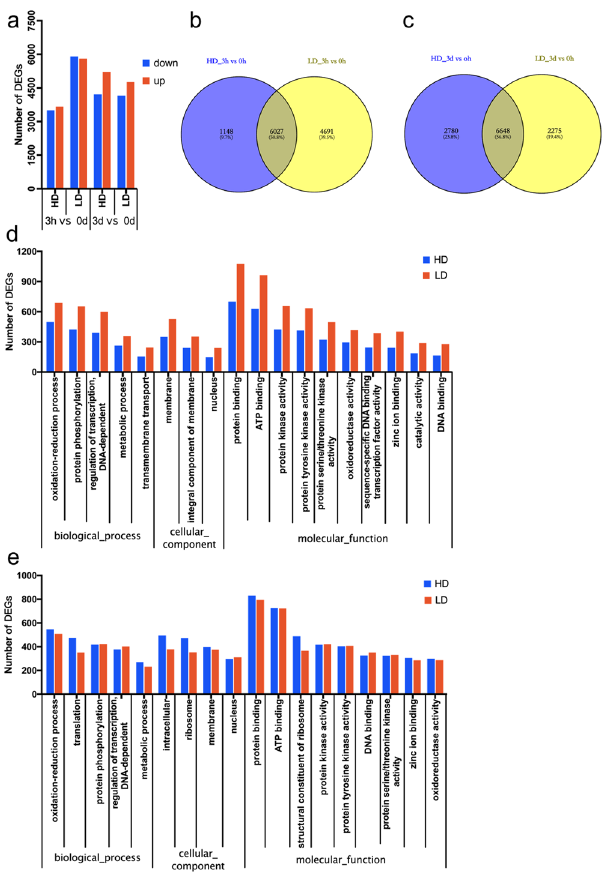
Figure 3. DEGs in four cotton cultivars during different-stage comparisons. ( a ) Number of DEGs at 3h vs 0h and 3d vs 0h; ( b , c ) Venn analysis of the DEGs in two types of cotton during different comparisons. ( d , e ) Go function analysis of DEGs at 3h vs 0h and 3d vs 0h,